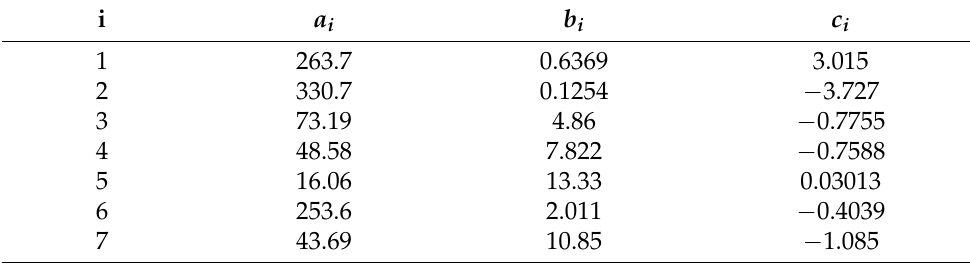
Table 1. Coefficients of the sinusoidal series describing the nasal breathing waveform (see Equation (6)).